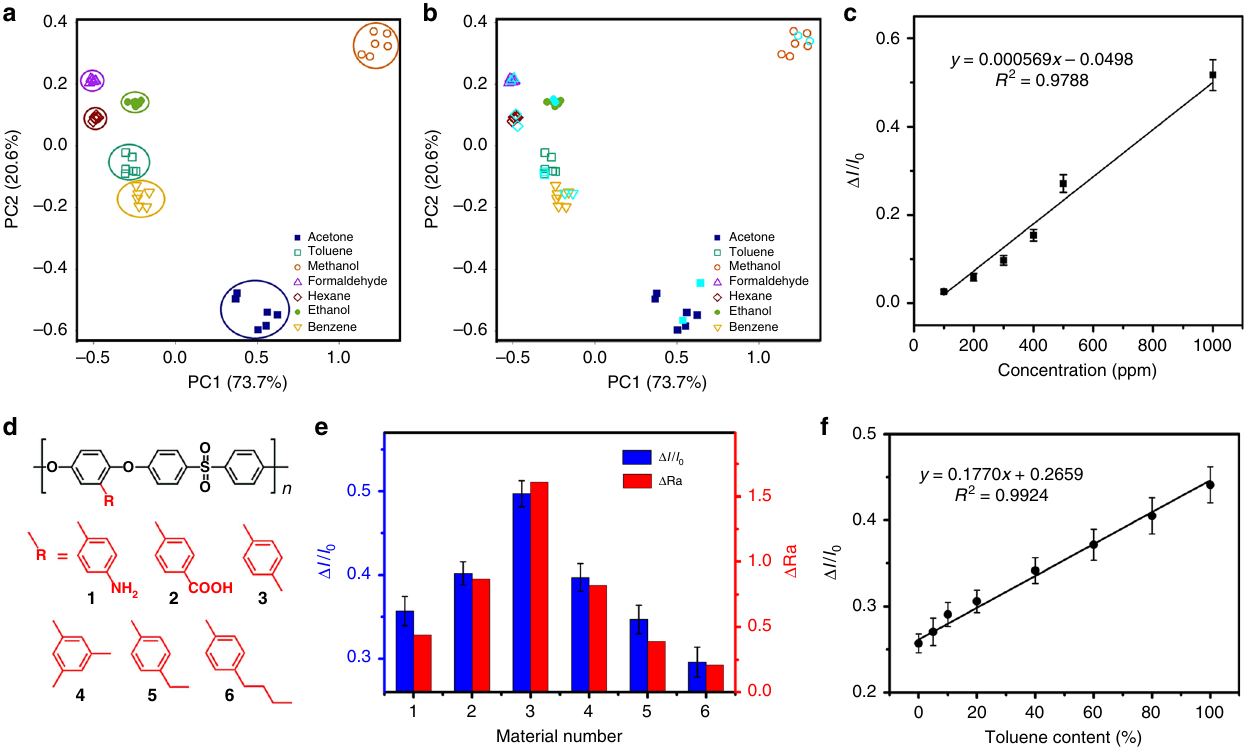
Fig. 4 Array-based organic vapors sensing and similar organic vapors identi fi cation. a PCA plot calculated from the fl uorescent intensity variation data obtained for arrays of eight polymer/AnPh 3 microwires during exposure to seven organic vapors, as presented by the fi rst two principal axes of PC1 and PC2. The used eight commercial polymers include poly(styrene-co-allyl alcohol), poly( α -methylstyrene), poly(vinyl chloride-co-vinyl acetate), poly(vinyl acetate), poly(carbonate bisphenol A), poly(ether sulfone), poly(methyl methacrylate), poly(vinyl butyral), and the AIE molecule is AnPh 3 . The PCA algorithm reveals that 94.3% of the variance in the data can be captured by PC1 and PC2, and shows that different types of the organic vapors are well separated. b Veri fi cation of the proposed classi fi cation method. Another two sets of data (sky-blue color) from these seven organic vapors are measured and evaluated whether the sensors can correctly identify organic vapors through the location of vapors in the PCA plot. The result reveals our proposed method can classify and identify different organic vapors well. c Relative variations of the fl uorescent intensity ( Δ I / I 0 ) for the poly(vinyl butyral)/AnPh 3 microwires in response to methanol vapor in low concentration, demonstrating a good linear dependency with low limit of detection of 100 ppm. Error bars, s.d. ( n = 20). d The molecular structures of six synthetic PESs with different pendant groups. The pendant groups include 4-aminophenyl, 4-carboxyphenyl, 4-methylphenyl, m-dimethylphenyl, 4-ethylphenyl and 4-butylphenyl groups. e Experimental result of benzene and toluene identi fi cation with polymer/ AnPh 3 microwires (blue column), and theoretical simulation result of variation of Hansen solubility parameters distance ( Δ Ra, red column). The used